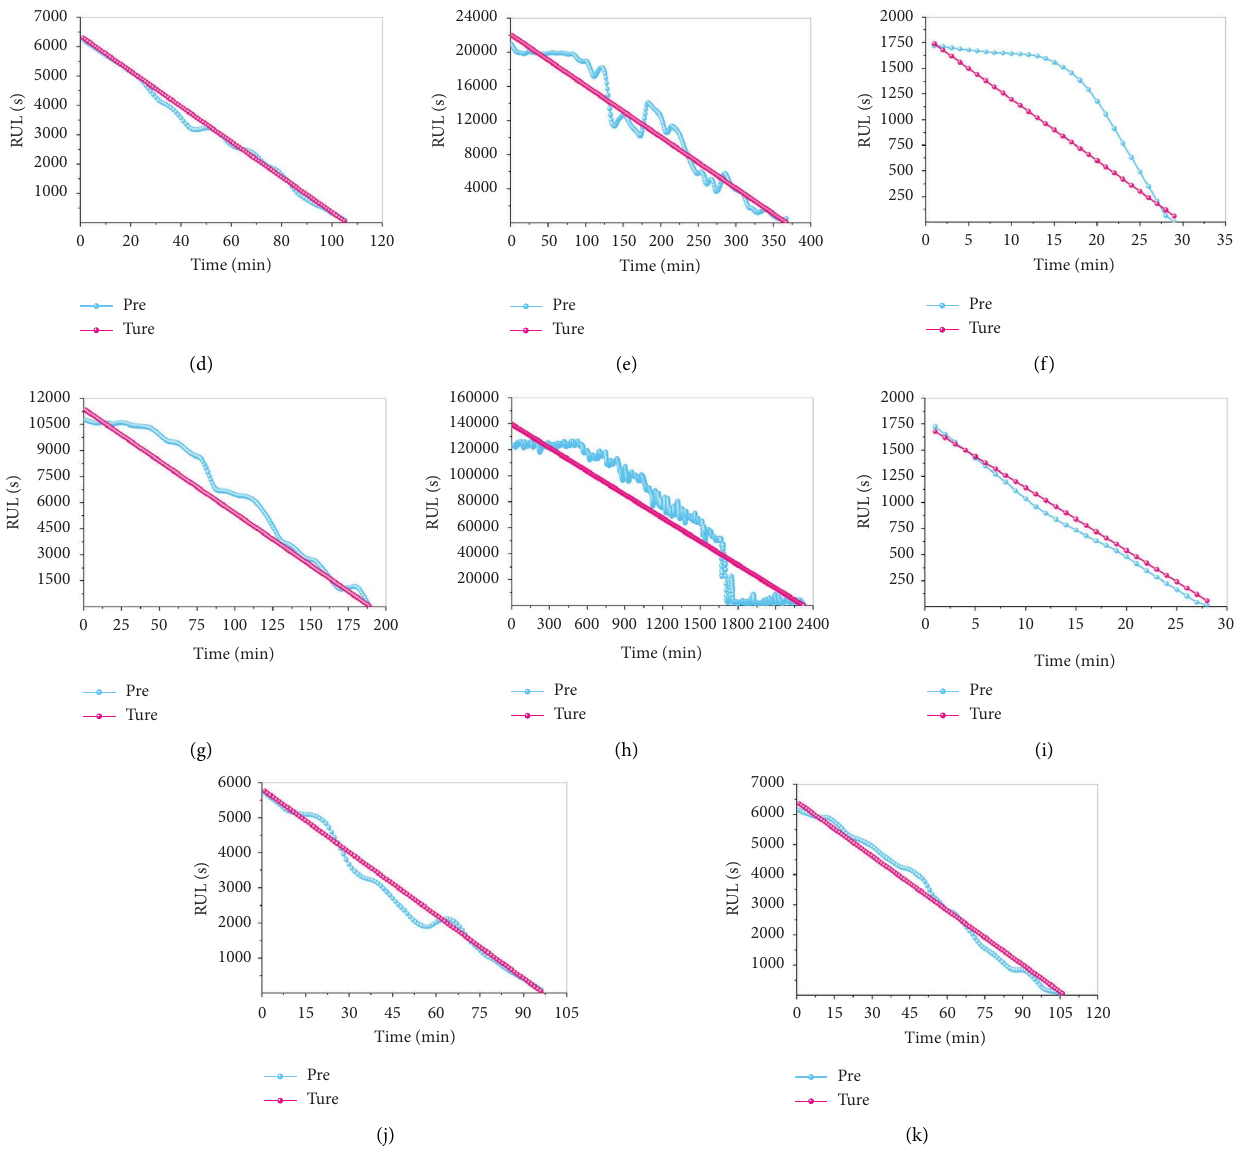
Figure 2: DELSTM training set testing results. (a) Bearing 1-1. (b) Bearing 1-3. (c) Bearing 1-5. (d) Bearing 2-2. (e) Bearing 2-3. (f) Bearing 2-4. (g) Bearing 3-1. (h) Bearing 3-2. (i) Bearing 3-3. (j) Bearing 3-4. (k) Bearing